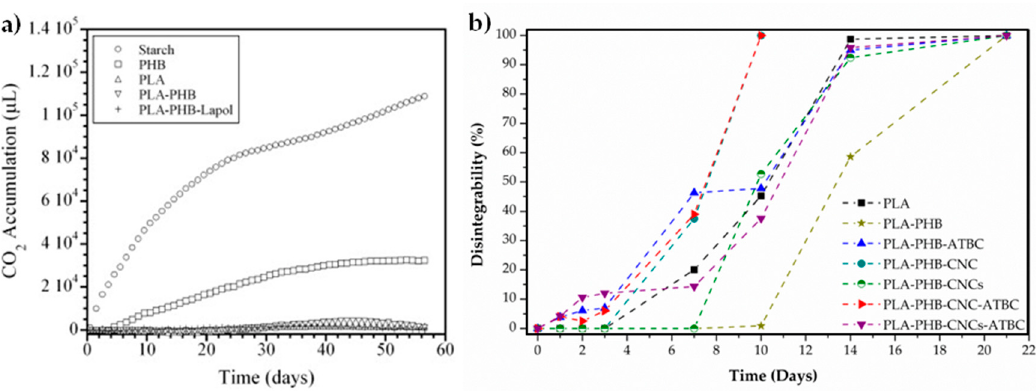
Figure 4. ( a ) Carbon dioxide evolution of the neat PLA, neat PHB, neat Starch (control), PLA-PHB and PLA-PHB-Lapol7% blends as a function of time. Reprinted with permission from [66];